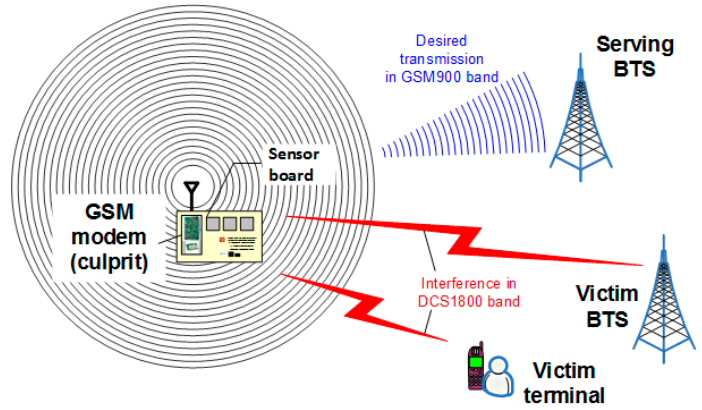
Figure 11. Interference caused by the GSM modem (concentrator) in 900 MHz band to a terminal and a BTS in 1800 MHz band.